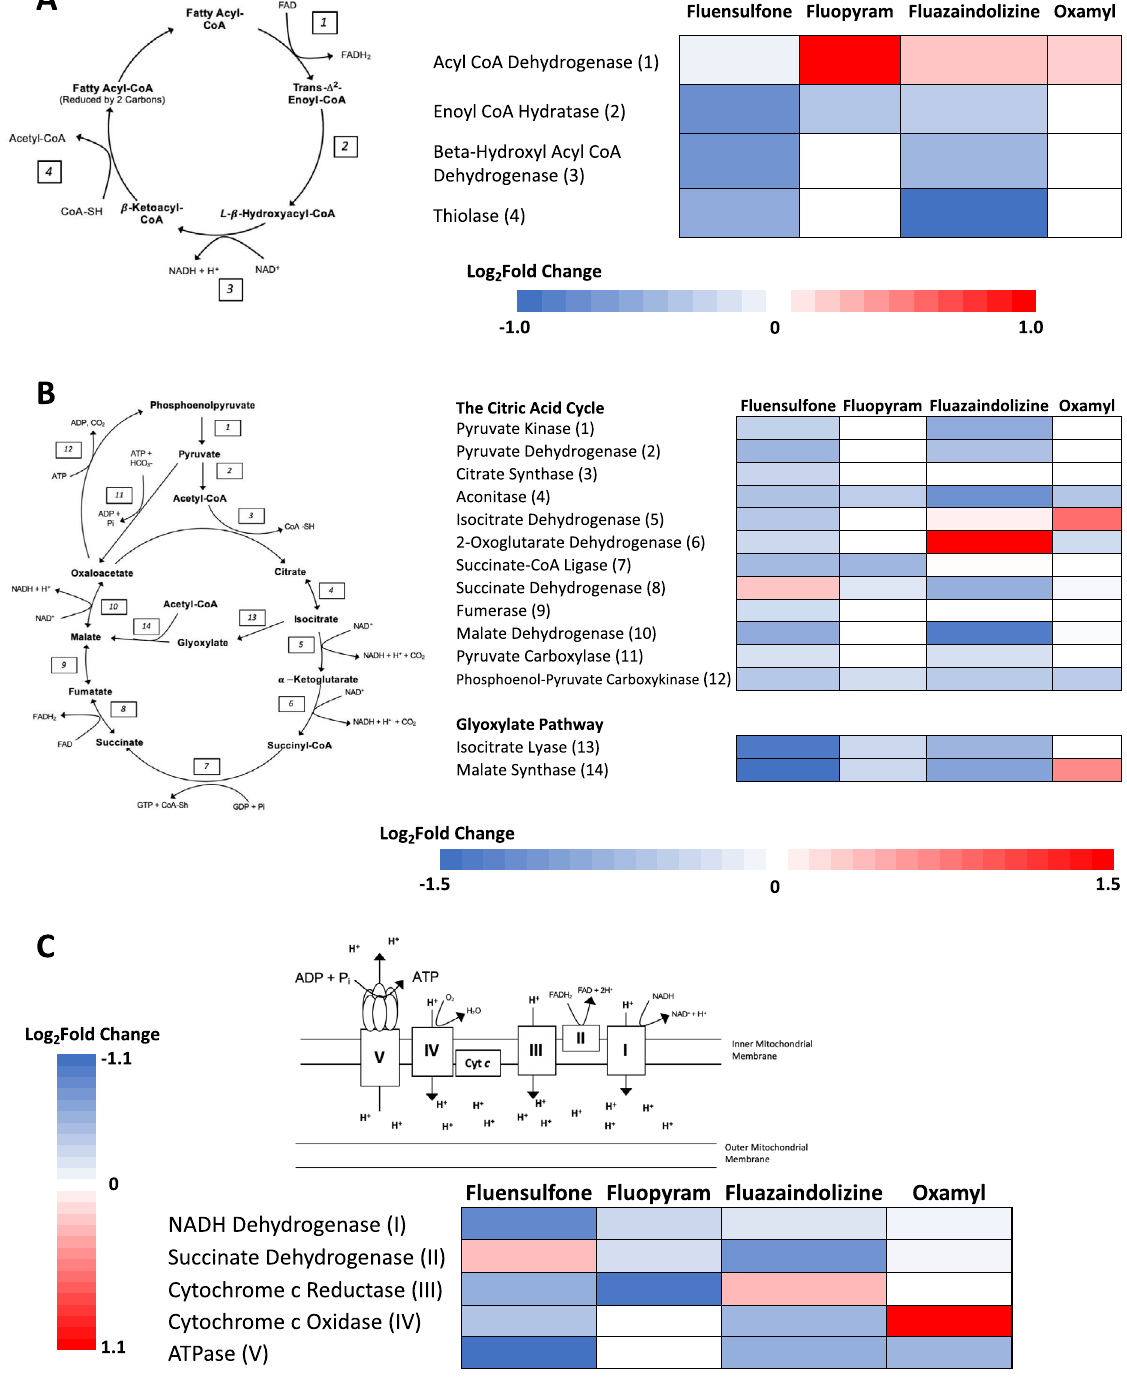
Figure 1. Gene expression summaries of major biochemical pathways in Meloidogyne incognita after exposure to nematicides. Meloidogyne incognita second-stage juveniles were exposed to fluensulfone, fluopyram, fluazaindolizine, and oxamyl for 24-h and high throughput sequencing used to determine gene expression compared to a water treated control (N = 4 replicates per treatment). In each panel, expression is in the form of Log 2 Fold Change (Log 2 FC); red and blue indicate upregulated or downregulated expression compared to control, respectively. Each Log 2 FC value shown represents the arithmetic mean of expression of significantly ( P < 0.05) differently expressed genes that were identified as that enzyme in M. incognita . The enzymatic steps in β -fatty acid oxidation are outlined along with their corresponding expressions of each enzyme in the pathway after nematicide exposure in panel ( A ). In panel ( B ), the citric acid cycle and the glyoxylate pathway are outlined with the corresponding expressions of each enzyme in the pathway after nematicide exposure. Panel ( C ), outlines the steps of oxidative phosphorylation and the corresponding expressions of each enzyme in oxidative phosphorylation after nematicide